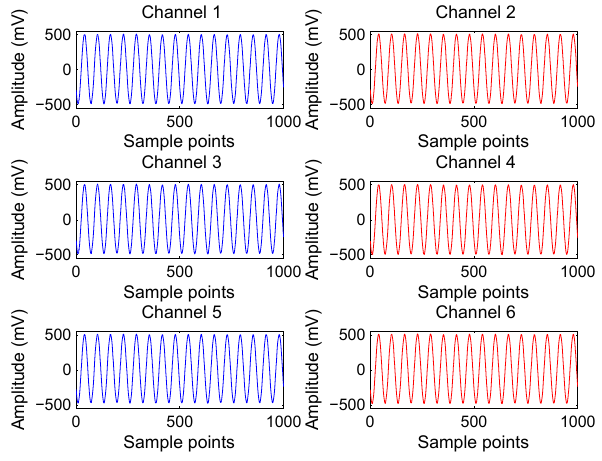
Figure 12. Sine waveforms received by six channels synchronously.